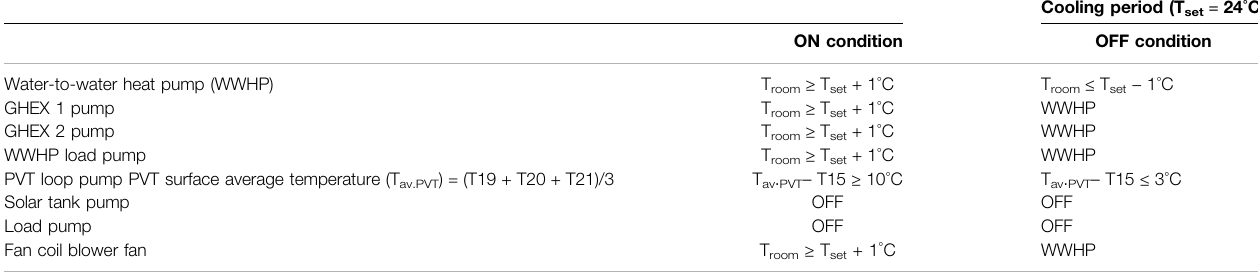
TABLE 2 | Hybrid solar – geothermal polygeneration control logic (Andrew Putrayudha et al.,